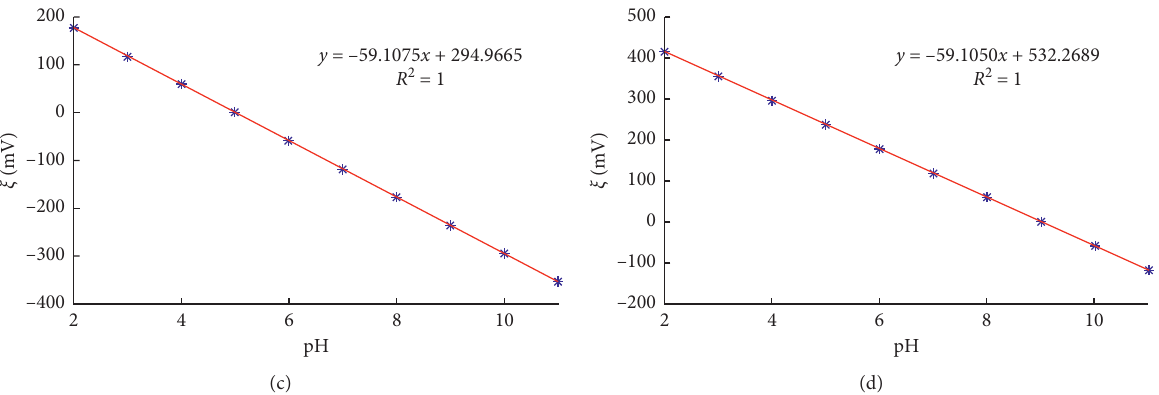
Figure 9: Total electrode potential ξ against pH for (a) TiO 2 , N s :12.05, ε s : 35, (b) Ta 2 O 5 , N s :10, ε s : 25, (c) Ta 2 O 5 , N s :12, ε s : 25, and (d) Al 2 O 3 , N s : 12.04, ε s : 10.43. The electrolyte is KCl for all